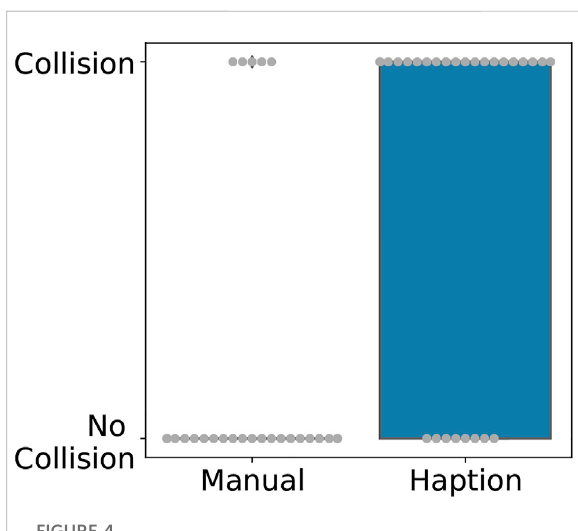
FIGURE 4 Boxplot with overlaid beeswarm plot comparing the occurrence of collisions between the probe and the glovebox fl oor per trial.